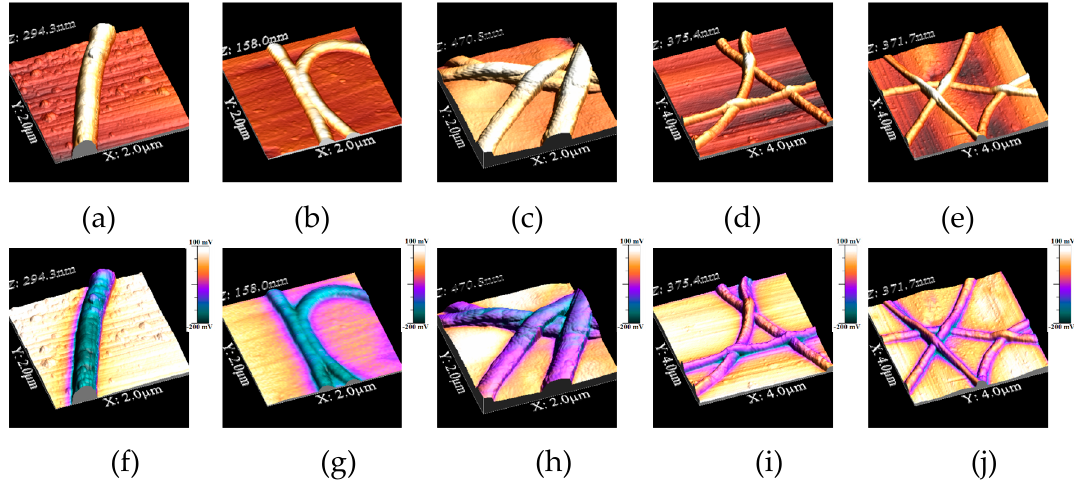
Figure 3. P(VDF-TrFE)/Graphene oxide composite fibers. ( a – e ) 3D topography image; ( f – j ) Topography with KPFM image (surface potential) over-imposed (colored coded). ( a , f ) 0% graphene oxide (GO); ( b , g ) 1% GO; ( c , h ) 5% GO; ( d , i ) 10% GO; ( e , j ) 20% GO.